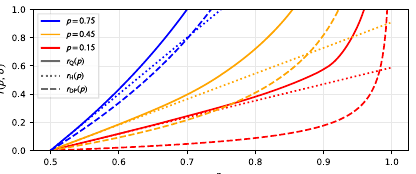
Fig. 5 Robustness bounds with depolarized input states. Compar- ison of robustness bounds for single-qubit pure states derived from quantum hypothesis testing r Q ( p ), Hölder duality r H ( p ), and quantum differential privacy r DP ( p ) 17 with different levels of depolarization noise p